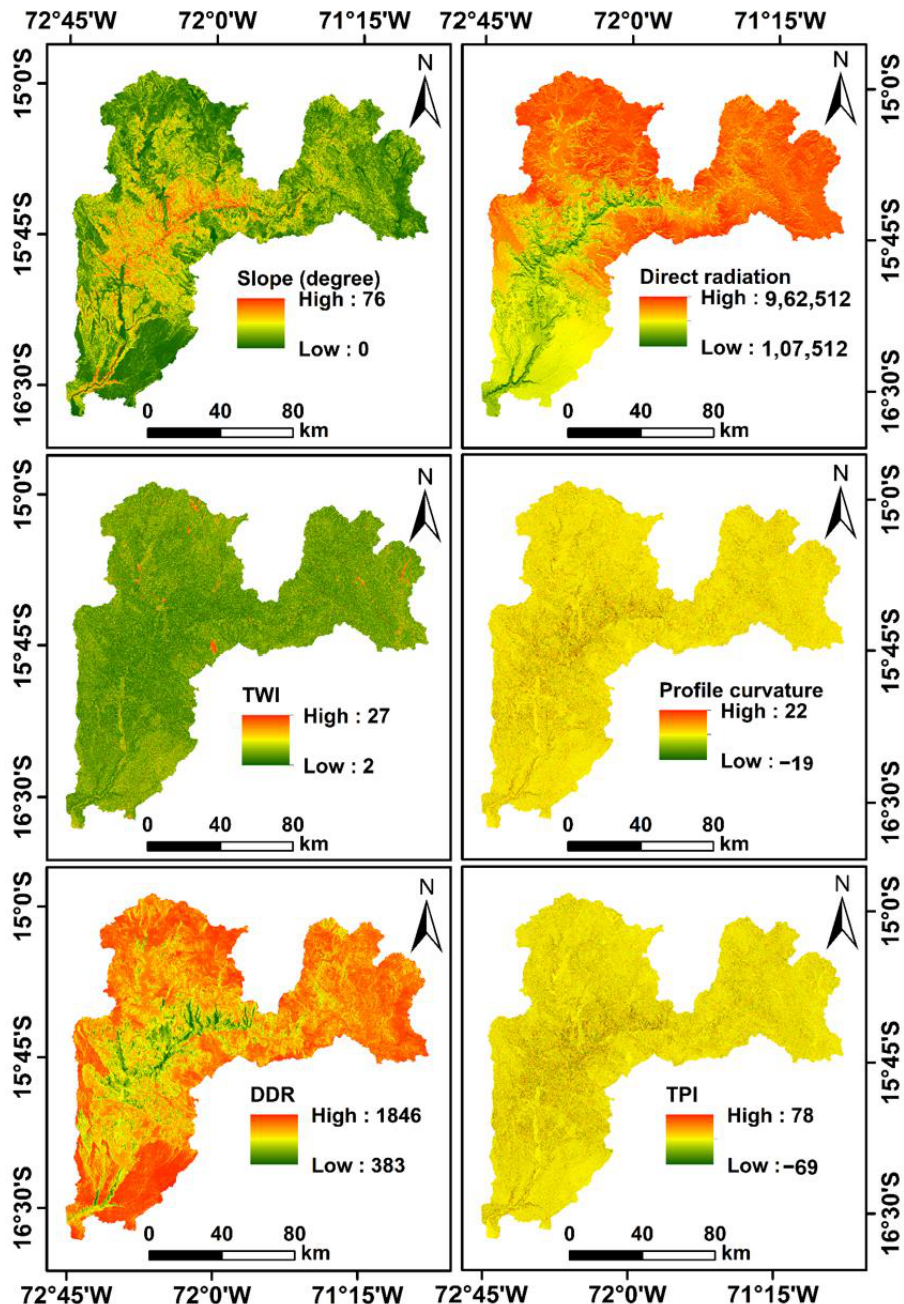
Figure 5. Six important LIFs prepared in the GIS environment. The remaining LIFs are presented in Figure S1.